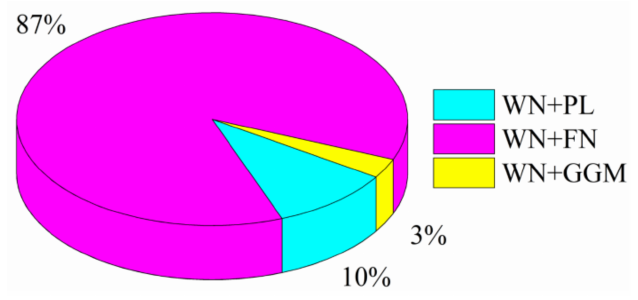
Figure 8. Distribution of optimal noise models before HYDL